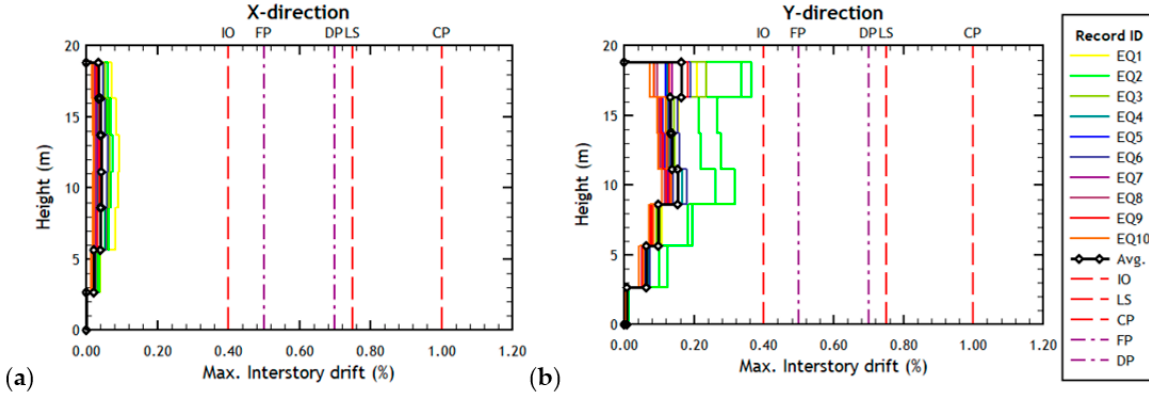
Figure 12. Interstory drift in ( a ) X-direction and ( b ) Y-direction, as obtained from THLA for the earthquakes in Table 3. The ASCE-SEI 41-17 (red dashed vertical lines) and ACHISINA limits (purple dash-dot vertical lines) are plotted in the figure for IO (immediate occupancy), LS (Life Safety), CP (Collapse Prevention), FP (Fragile partitions), and DP (Ductile Partitions).